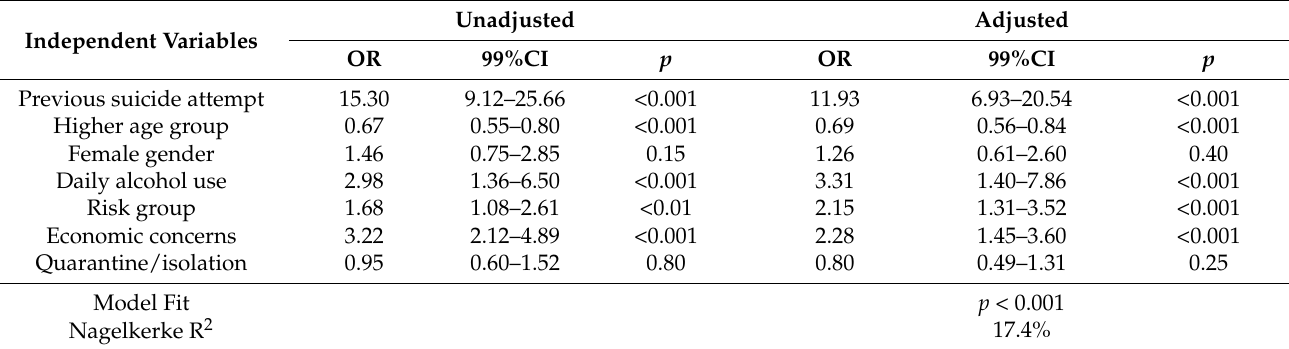
Table 2. Associations with suicide thoughts last month ( n =